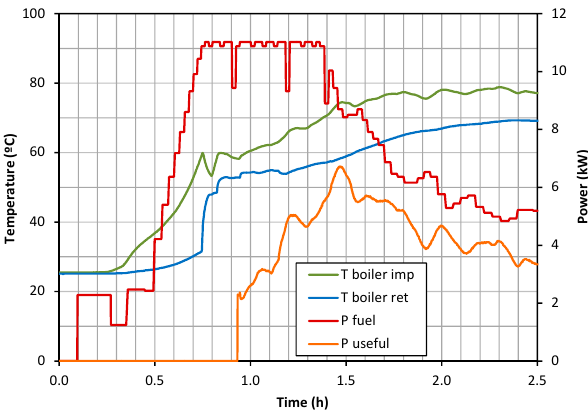
Figure 9. Temperature and power during the combustion test of COM.